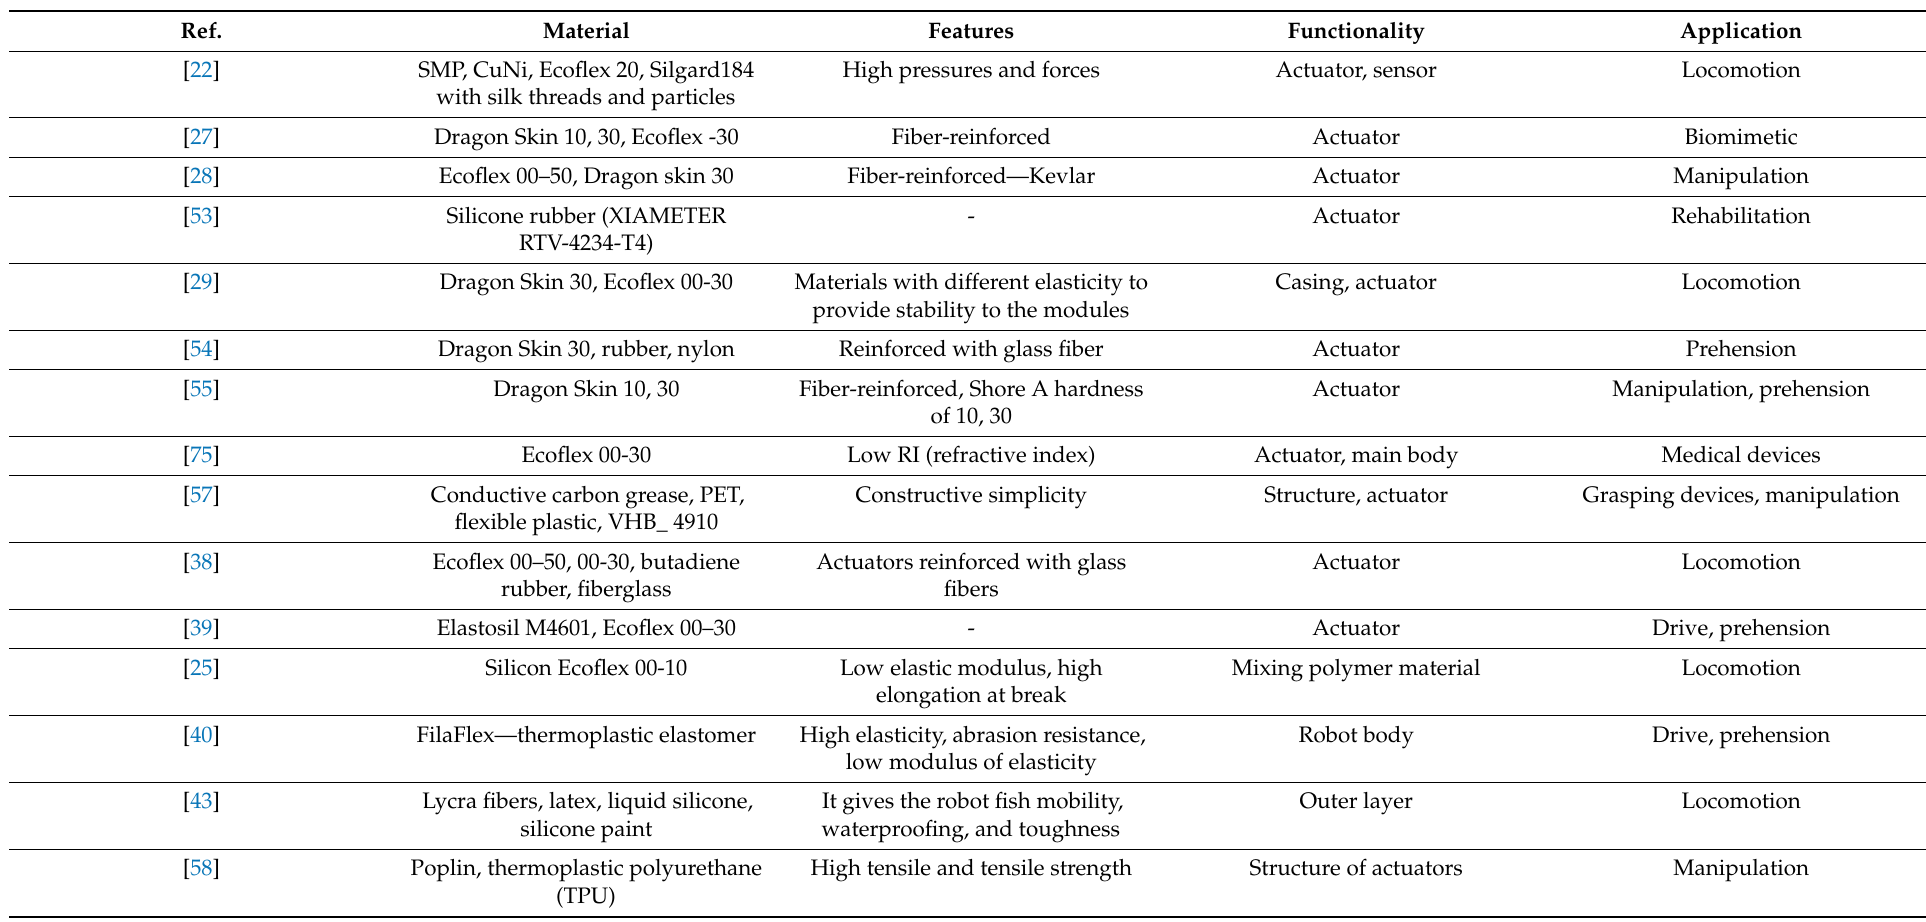
Table A2. Analysis of bibliographic references according to the